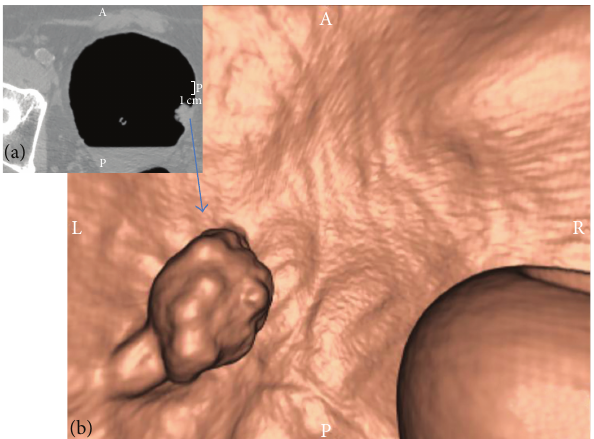
Figure 1: Exophytic lesion arising from the left side of the bladder wall. (a) MDCT image (transverse plane) and (b) VC image (after 3D reconstruction). The pathology report revealed a pTa TCC of the bladder. On the right side of the VC image (b) the balloon of the catheter can be